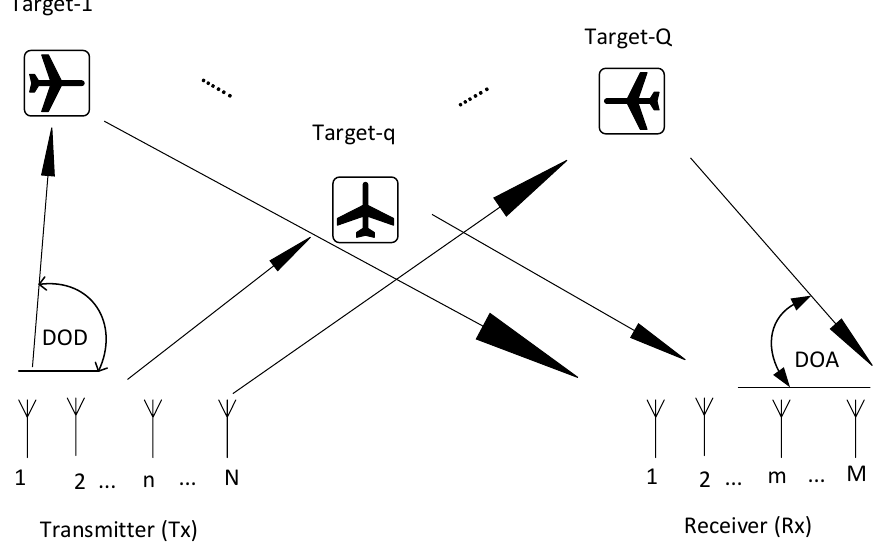
Figure 1. Co-Located Radar Figure 1. Co - Located Radar System.